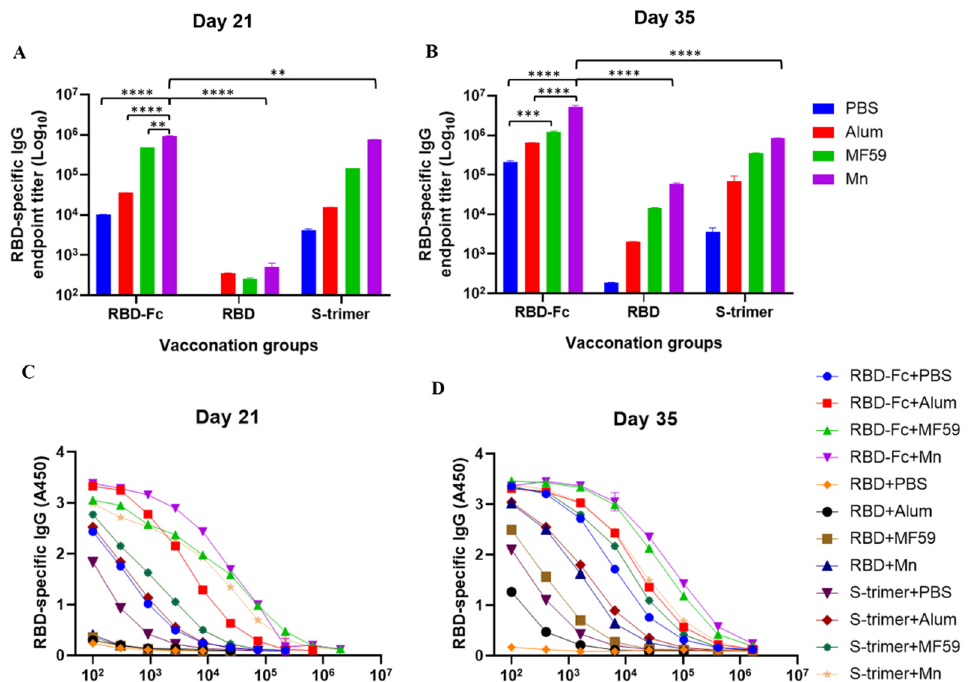
Figure 2. RBD-specific IgG detection in immunized mouse sera. The IgG in immunized mouse sera were detected with ELISA using the RBD protein to coat the plates. ( A ) RBD-specific IgG endpoint titer on day 21 in all groups of immunized mice. ( B ) RBD-specific IgG endpoint titer on day 35 in all groups of immunized mice. ( C ) The curve of RBD-specific IgG in immunized mice on day 21. ( D ) The curve of RBD-specific IgG in immunized mice on day 35. Geometric mean was calculated for each set of data, as shown and compared. Statistical significance was determined by two-way ANOVA and is indicated as follows: ** p < 0.01, *** p < 0.001, **** p < 0.0001. Error bars represent SD.